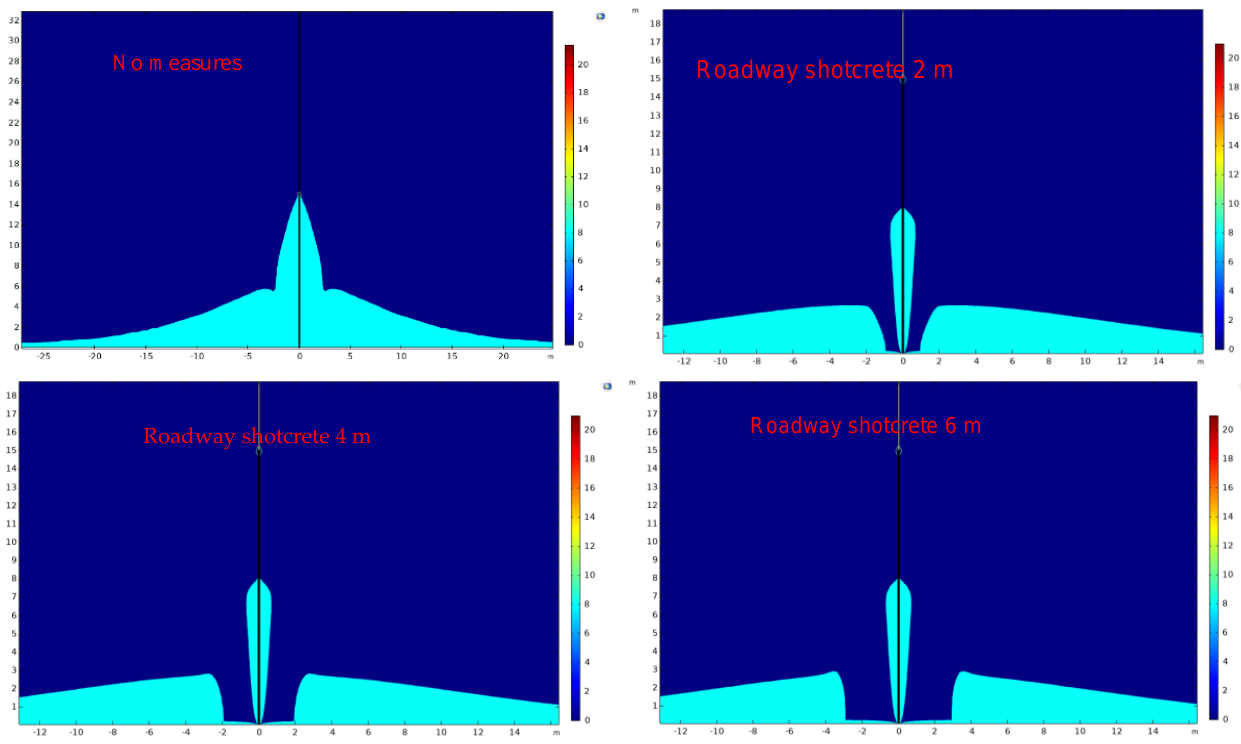
Figure 5. Changes of hazard areas under different roadway grouting lengths when the gas was extracted for 3 d.